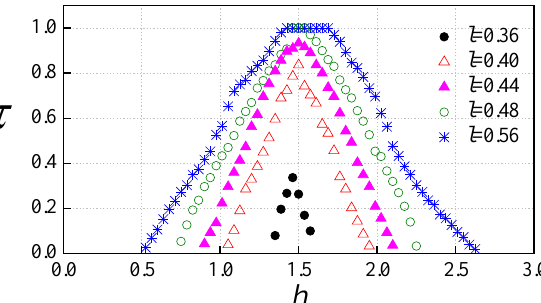
Figure 7. Relationship between the possibility of vortices occurring ( τ ) and the dimensionless height ( h ) under different dimensionless widths of the inlet fall ( l) ( q = 0.23).